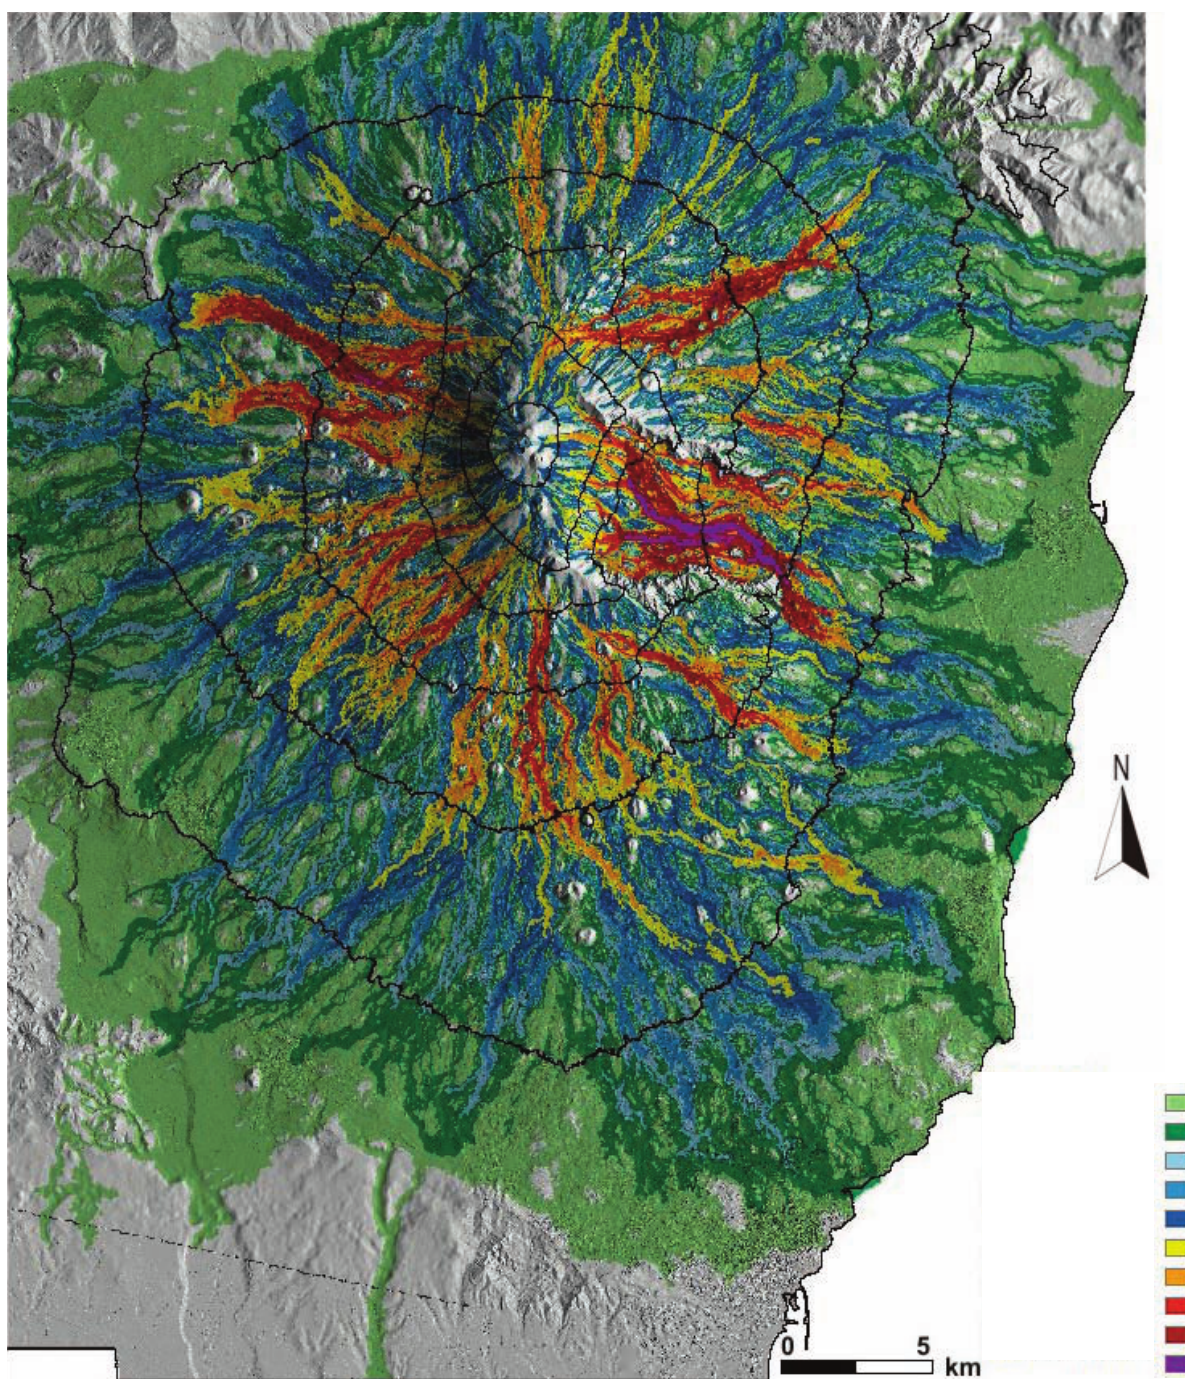
Figure 5. High-detail hazard map of Mount Etna from all of the simulations and from the application of Equation (2), representing the probabilities of the areas to be affected by future